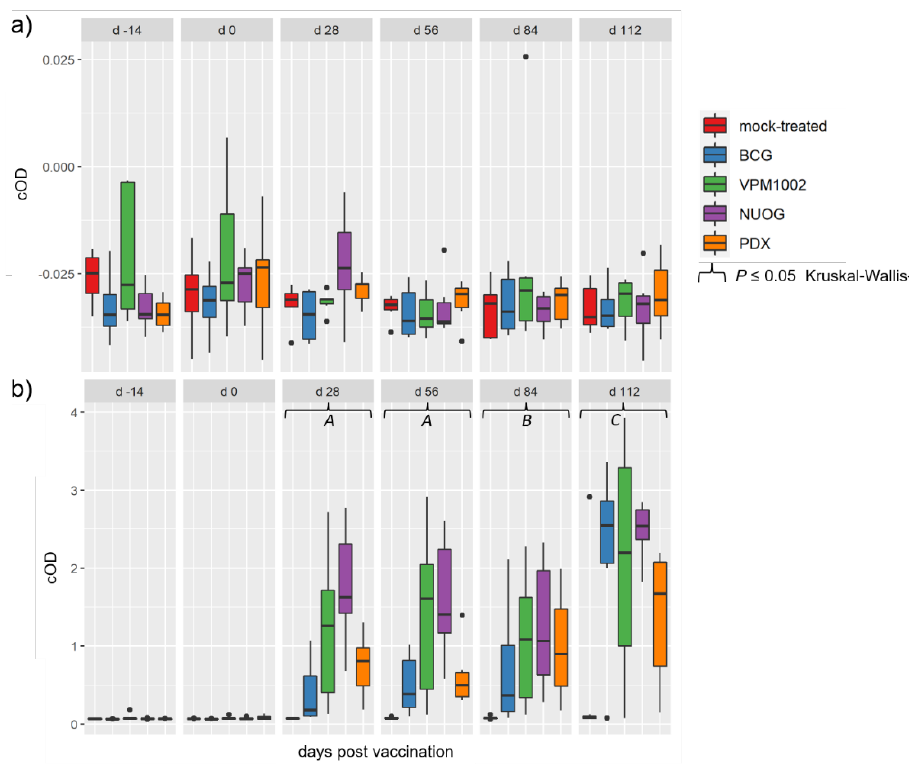
Figure 9. Humoral response to mycobacterial antigens of goats vaccinated with either BCG, VPM1002, NUOG, PDX, or the mock-treated control. ( a ) Antibodies recognizing M. bovis antigens (MPB70 and MPB83) and ( b ) M. avium ssp. paratuberculosis (MAP) antigens detected by respective ELISA tests (see Materials and Methods for details). ( A ) All vaccinated groups significantly differed from the mock-treated group. The MAP antibody response of the NUOG group significantly exceeded that of the BCG and PDX groups. ( B ) All vaccinated groups were statistically significantly different from the mock-treated group. ( C ) The BCG-, NUOG-, and PDX-vaccinated groups significantly differed from the mock-treated groups. The NUOG group response significantly exceeded that of the PDX